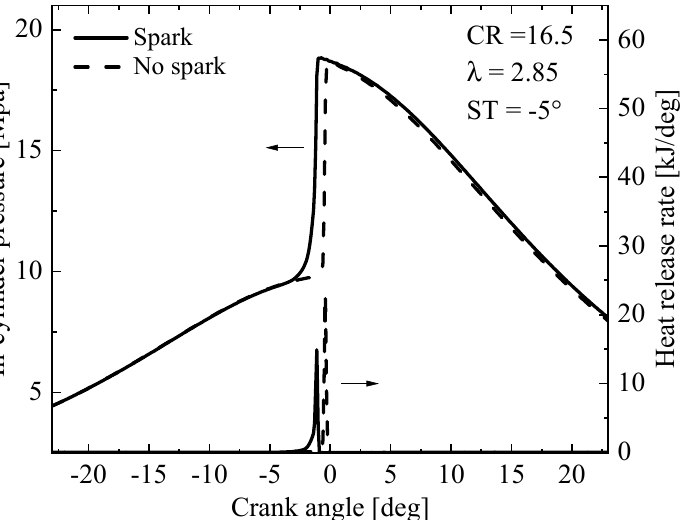
Figure 5. Effect of the spark plug on the predicted pressure and heat release rate traces for the baseline